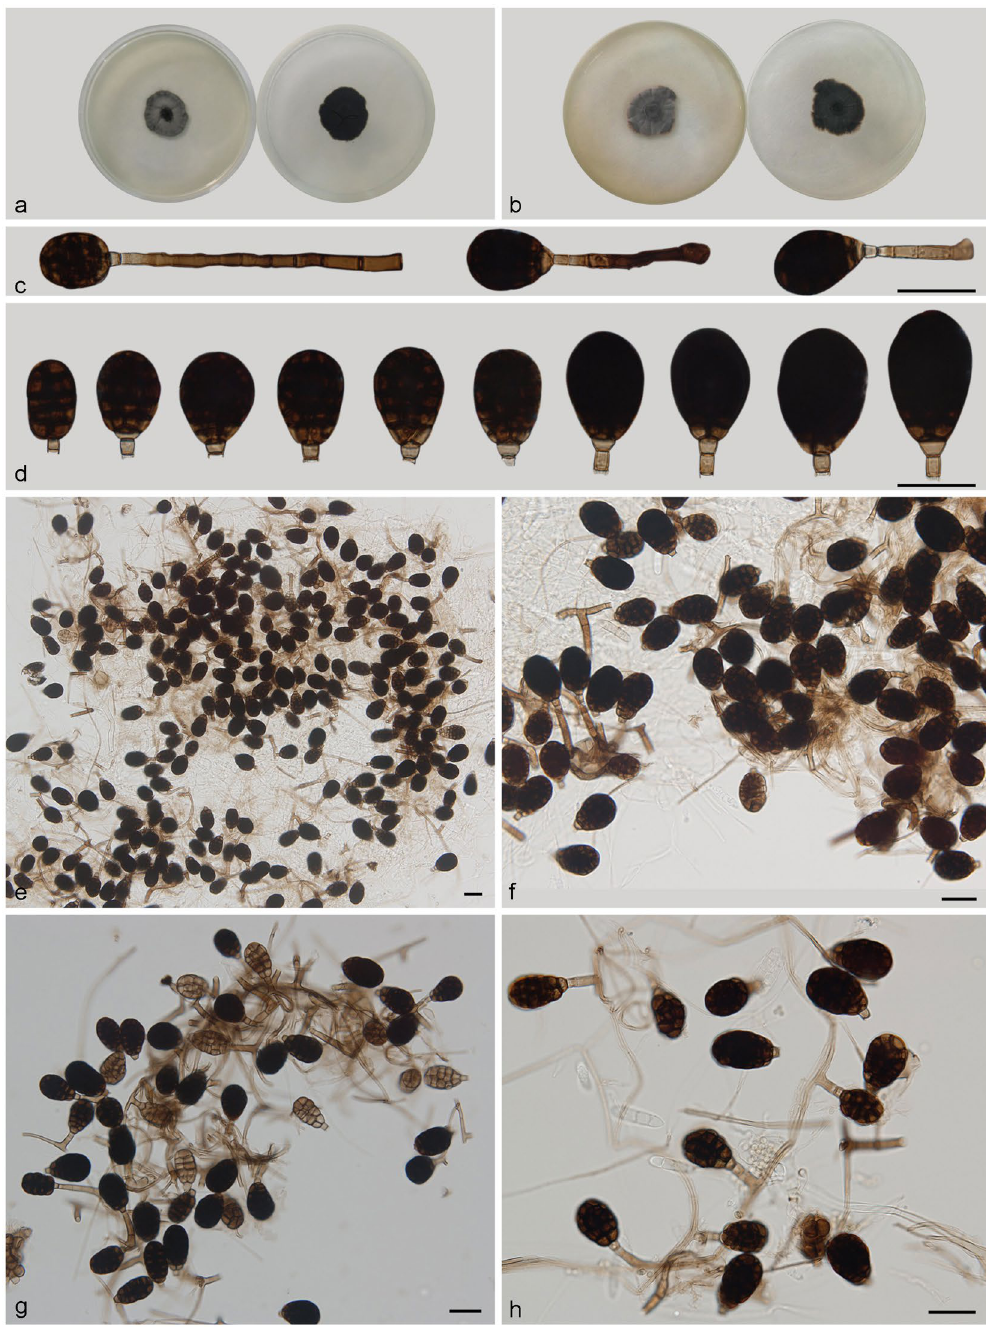
Figure 14. Rhexoacrodictys erecta. ( a ) Colony on PDA (surface and reverse). ( b ) Colony on MEA (surface and reverse). ( c , d ) From natural substrate (HSAUP H4622): ( c ) Conidiophores, Conidiogenous cells and conidia, ( d ) Conidia. ( e – h ) From PDA (CGMCC 3.18656): Conidiophores and conidia. — Scale bars = 20 μ